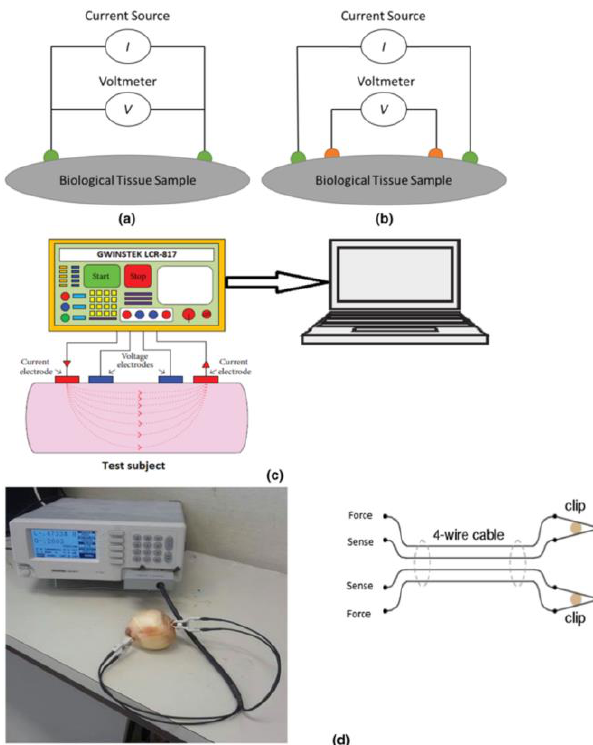
Figure 6. Electrical impedance measurement diagram [11]: ( a ) two-electrode impedance measure- ment method; ( b ) four-electrode impedance measurement method; ( c ) schematic diagram of onion moisture EIS measurement; ( d ) electrical impedance spectroscopy measurement experimental system (reprinted from Ref. [11]).